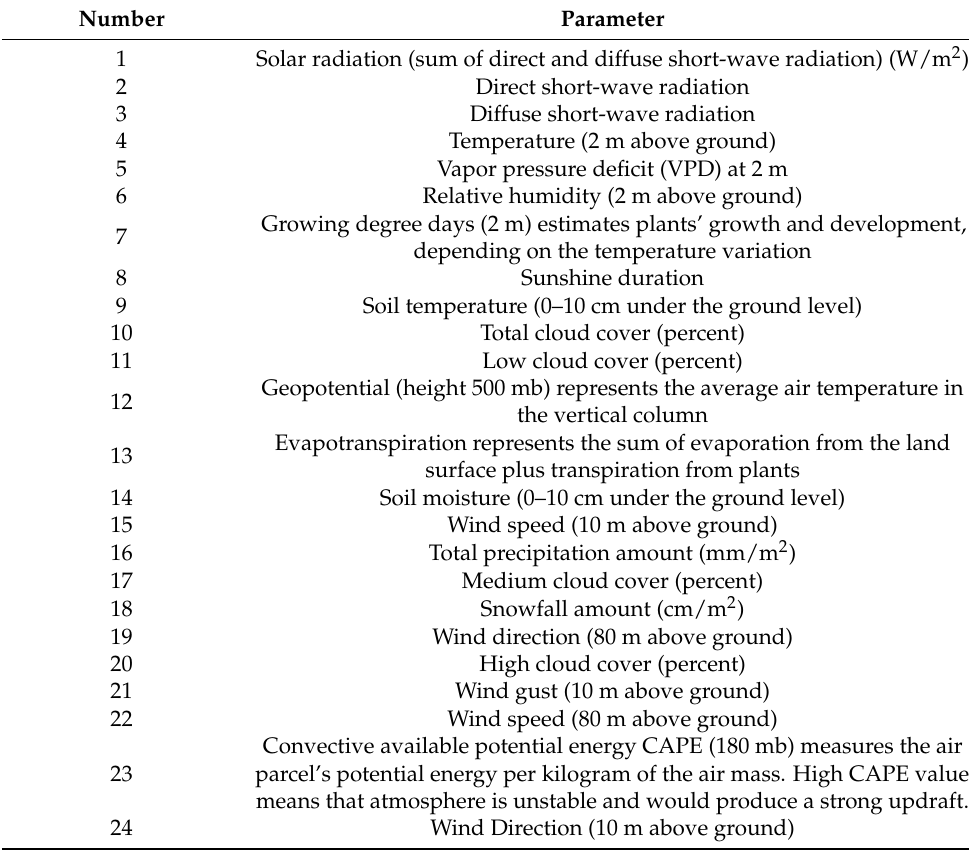
Table 1. The twenty-four parameters employed in our study for solar radiation